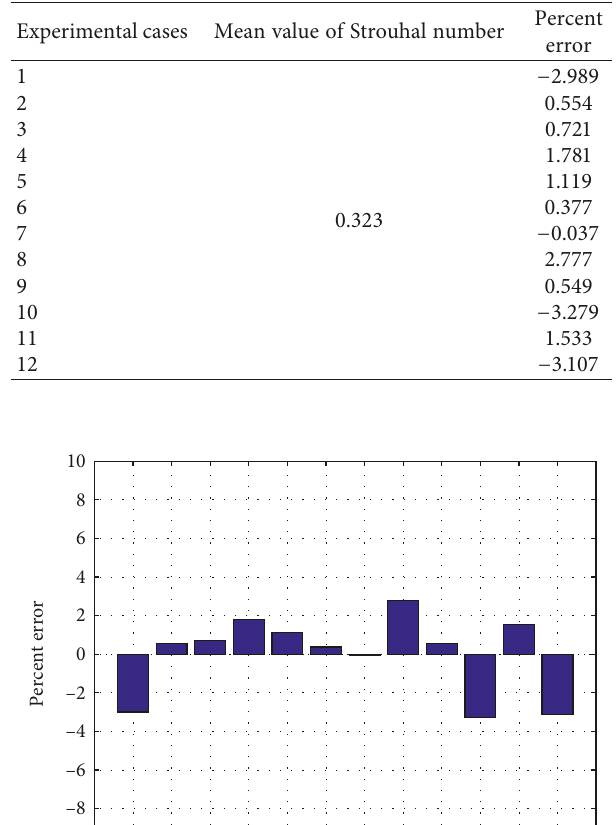
Table 3: Strouhal number estimation with dynamic wind tunnel